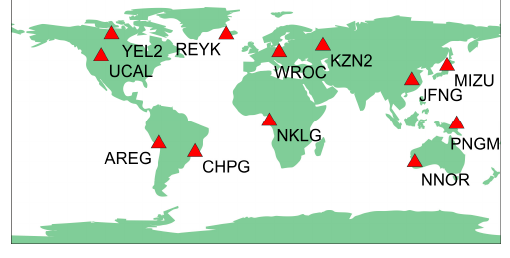
Figure 1. Distribution of test stations. Table 1. Station equipment and observations types used; originally leading C and P letters (denoting pseudorange and carrier-phase observation type, respectively) were replaced by a letter indicating the Global Navigational Satellite Systems (GNSS): G for GPS, R, for GLONASS, E for Galileo, and C for BeiDou (see RINEX 3.03 for signal specification [36]).